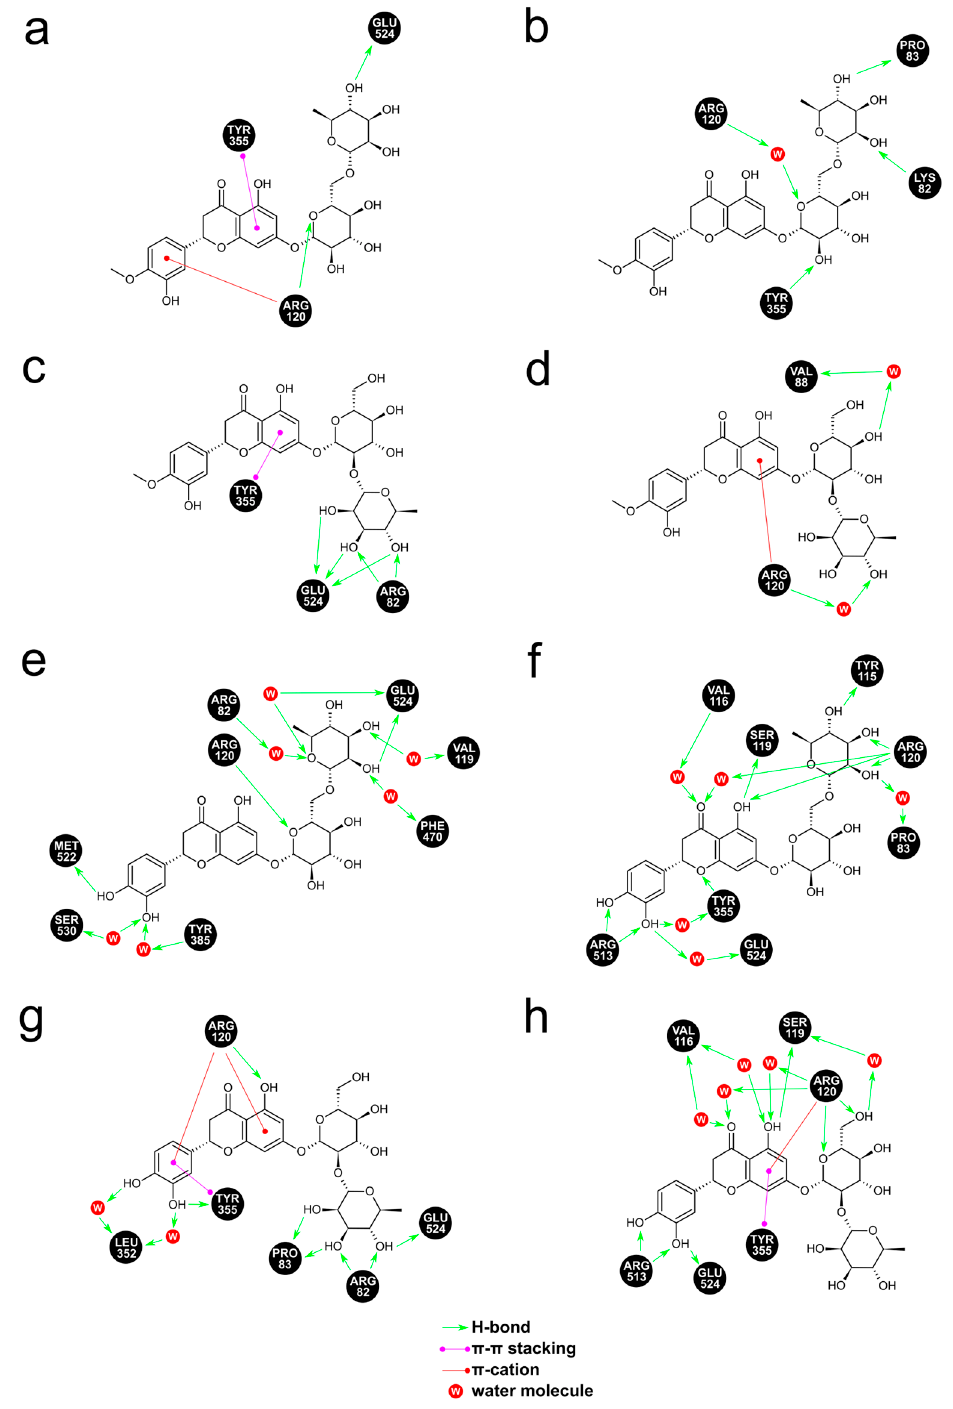
Figure 2. Protein/ligand interaction of ( a ) HED/COX-1; ( b ) HED/COX-2; ( c ) NHE/COX-1; ( d ) NHE/COX-2; ( e ) ERI/COX-1; ( f ) ERI/COX-2; ( g ) NER/COX-1, and ( h ) NER/COX-2. During the MD simulations of the compounds bound to COX-1, HED (Figure 2a) MD trajectories were used to estimate the difference in protein/ligand interaction energy (see Section 2.4.) for each ligand between the two COX isoforms ( ∆ E COX-2-COX-1 ). makes hydrogen bonds with Glu524 and Arg120 by its disaccharide moiety. By its The resulting values (Table 4) suggest a marked selectivity towards COX-2 of the eriodyctiol- fl avanone moiety, HED forms a π –cation interaction with Arg120 and π – π stacking with based compounds, i.e., ERI and Tyr355. NHE (Figure 2c) makes hydrogen bonds between its disaccharide moiety and Glu524 and Arg83. The fl avanone moiety of NHE forms π – π stacking with Tyr355. The disaccharide moiety of ERI (Figure 2e) makes hydrogen bonds with Arg120 and water- mediated hydrogen bonds with Glu524, Arg82, Val119, and Phe470. Moreover, the